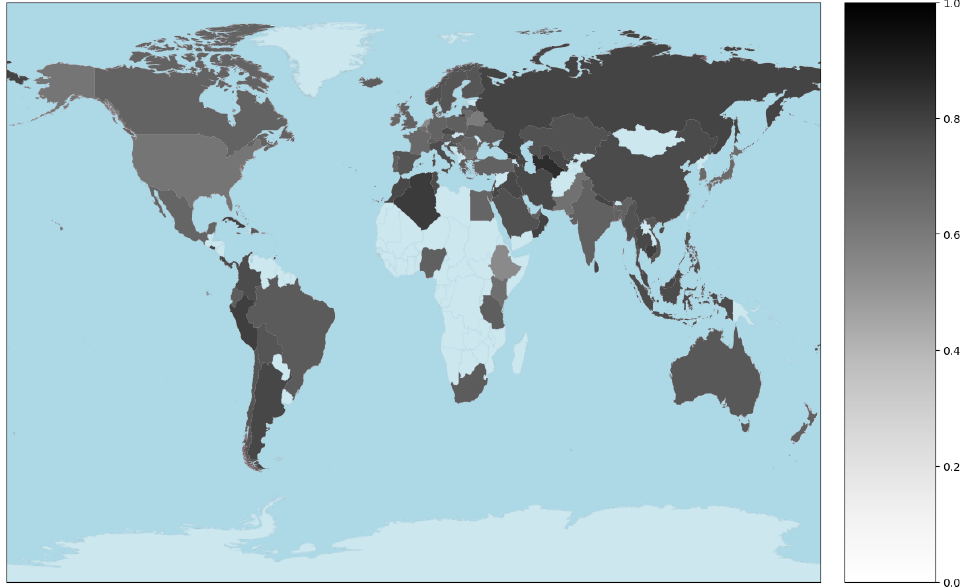
Figure 5. Average area under FRD for all countries in this